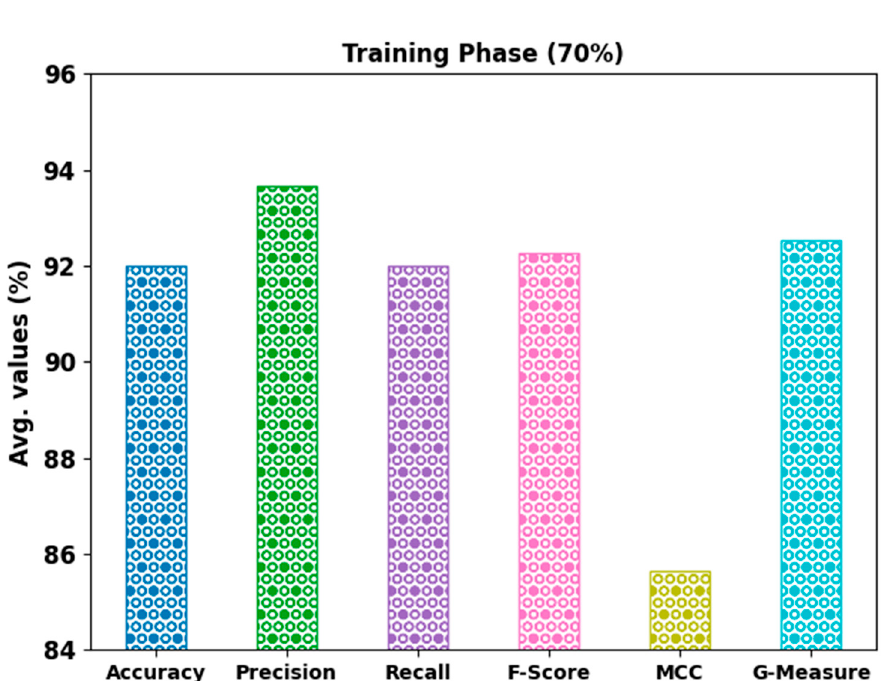
Figure 6. Average analysis of AHBATL-MNC approach under 70% of TR database.